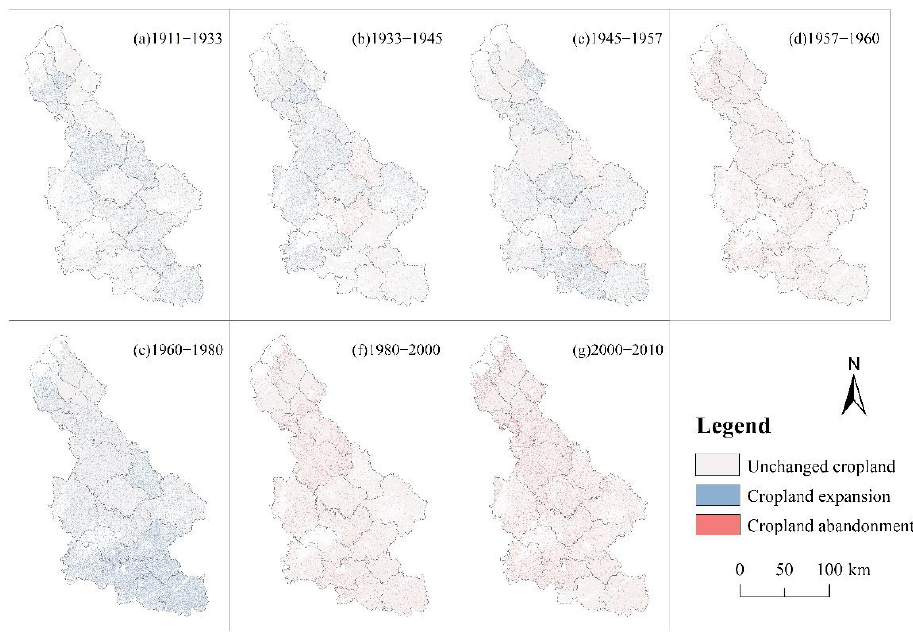
Figure 6. Cropland changes in the Tuojiang River Basin from 1911–2010 ( a – g ).